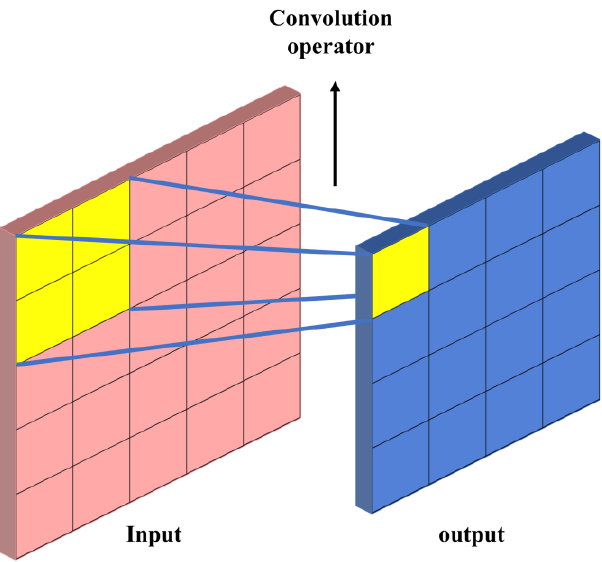
Figure 1. General structure of a convolution (2 × 2 convolutional operator).